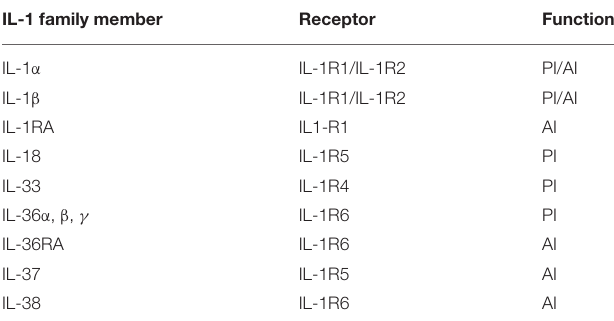
TABLE 1 | IL-1 family of ligands and receptors (adapted from Dinarello,